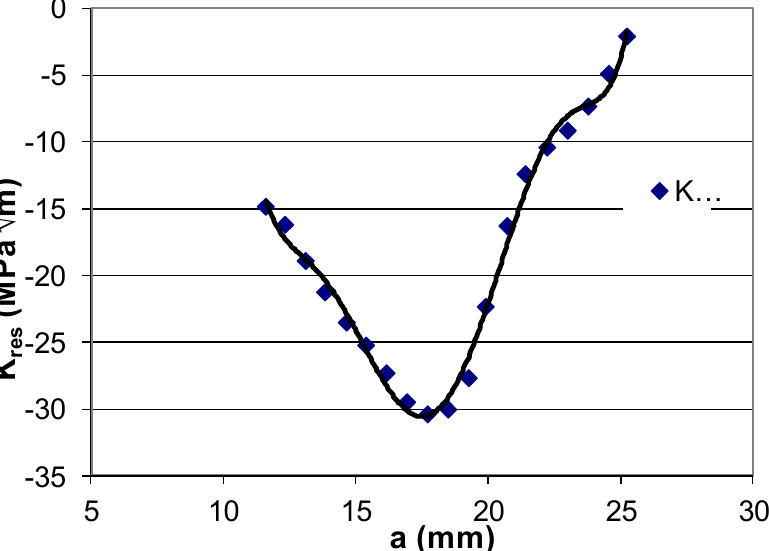
Figure 2. The dependency of residual stress intensity factor ( K res ) versus crack length ( a ); from [72].